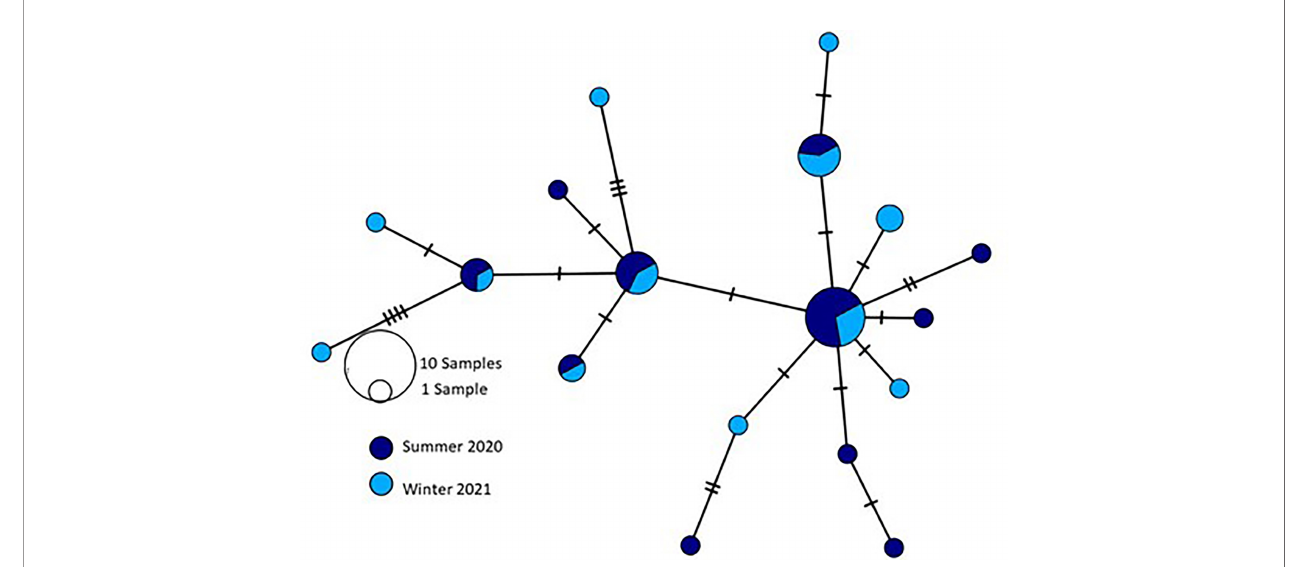
FIGURE 10 | Median-joining network showing the relationships between 18 haplotypes detected by sequencing R. nomadica collected from the coast of Israel during summer 2020 and winter 2021 for the partial mitochondrial DNA cytochrome oxidase I (mtCOI) region. Circle sizes are approximately proportional to haplotype frequency: the smallest circle represents a single individual; the largest circle represents 10 individuals. Each connection represents a single mutation, and small open black dots represent missing intermediate